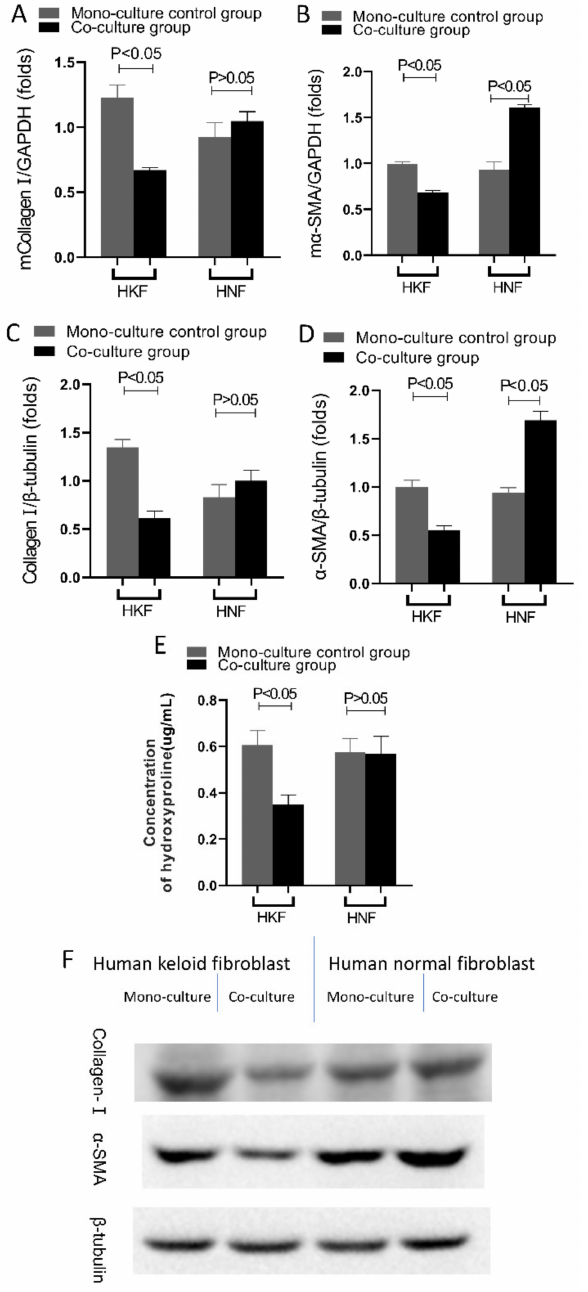
Figure 8. HDPSCs inhibits extracellular matrix synthesis of HKFs and HNFs. ( A ) After 24 h of culture and then subjected to RT-qPCR and Western blot. Quantification of ( A ) Collagen I, and ( B ) α -SMA gene expression, normalized to GAPDH expression. Quantification of ( C ) Collagen I, and ( D ) α -SMA protein levels, normalized to β -tubulin expression levels ( E ) Cell culture supernatants were collected and tested for hydroxyproline content. ( F ) Gels were analyzed by immunoblotting using the indicated